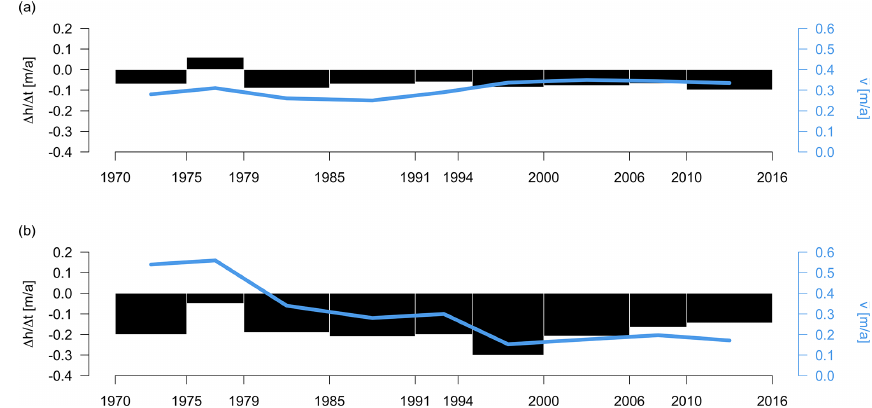
Figure 8. Mean vertical changes (black columns) and horizontal velocities (blue line) of the periglacial part of the rock glacier (a) and the glacier-affected part of the rock glacier (b) from 1970 to 2016. The values of the period 1970 to 1995 result from Kääb et al.